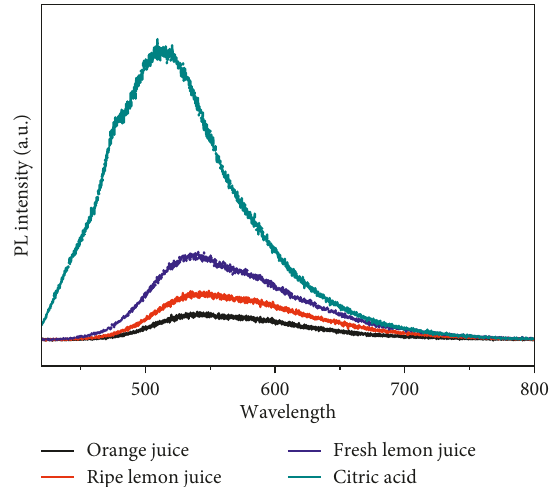
Figure 7: Luminescence of C-dots synthesized from citric acid and different natural sources.